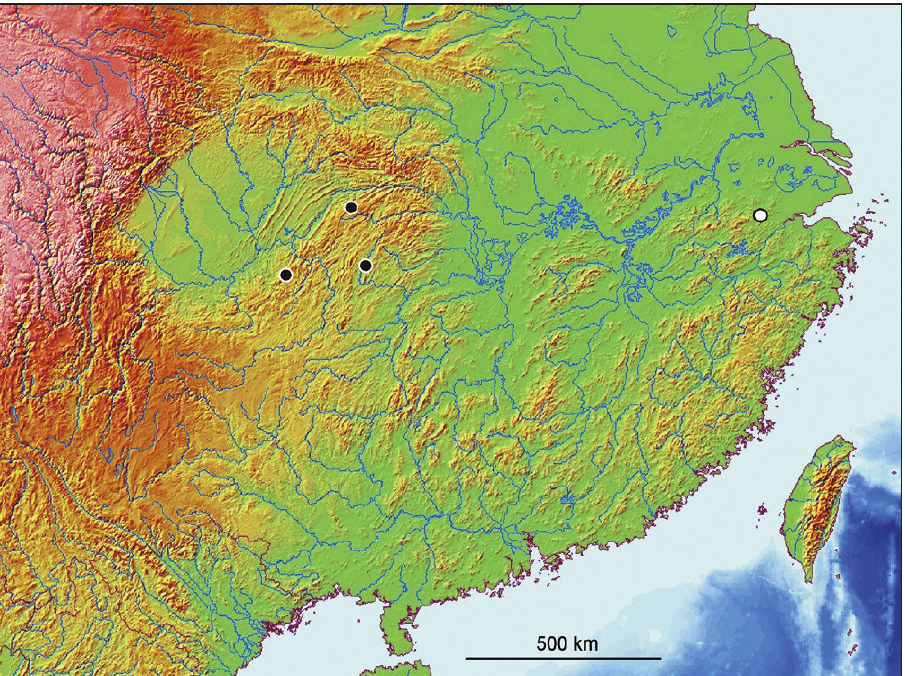
Figure 13. Distribution of Apteroloma zhejiangense sp. n. (empty circle) and A. jinfo (filled circles) in